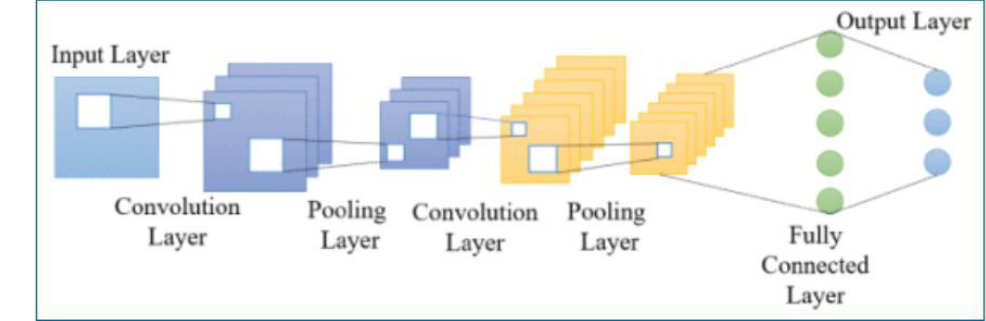
Figure 2. CNN's fundamental framework